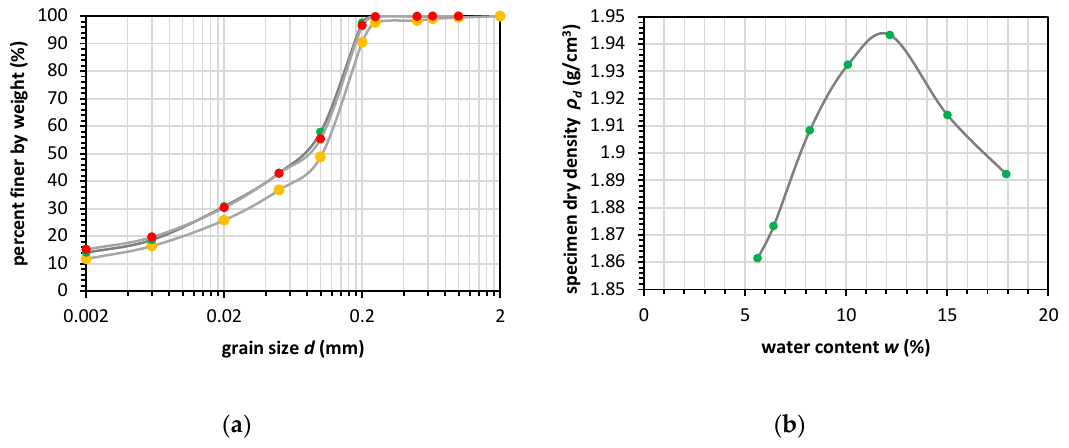
Figure 5. Soil respond to repeating loading in strain-controlled test ( a ) and stress-controlled test ( b ). Figure 5. Cohesive soil physical properties, the results of the granulometric study ( a ), the result of the Proctor test ( b